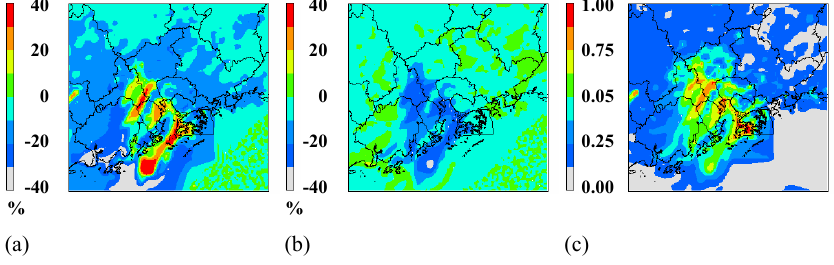
Fig. 15. Regional distribution of the percentage change in P (O x ) due to a 25% reduction in anthropogenic emissions of NO x only (a) , VOCs only (b) , and the NO x /NO y ratio in the base case run (c) in the surface layer during 12:00–13:00LST on 16 October 2004.